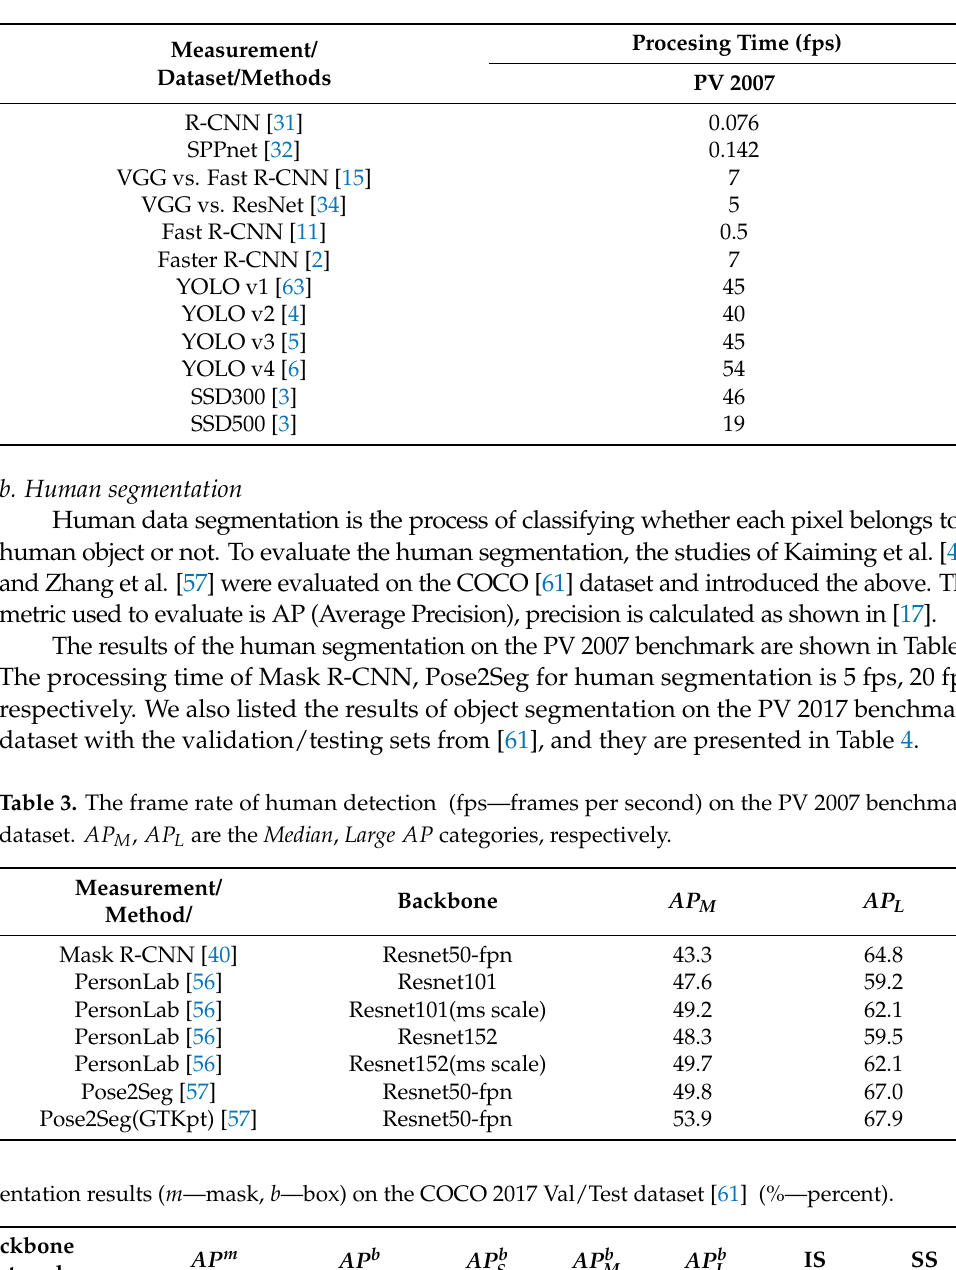
Table 4. The object segmentation results ( m —mask, b —box) on the COCO 2017 Val/Test dataset [61] (%—percent). Measurement/ CNNs